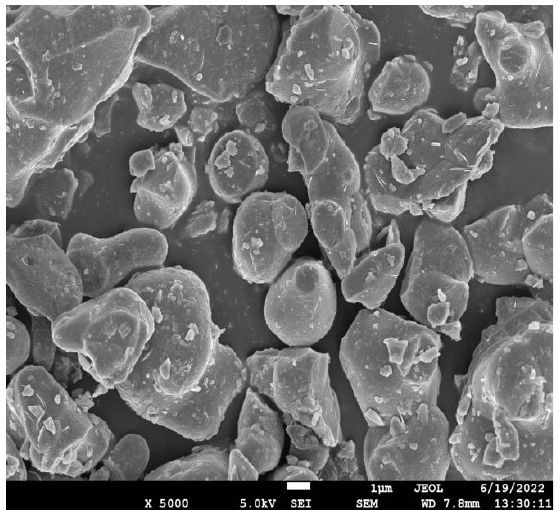
Figure 2. SEM image of C 3 S. Table 1. Particle size of C 3 S.